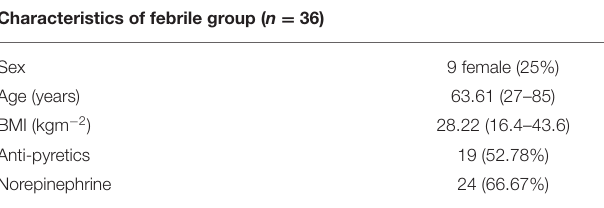
TABLE 1 | Characteristics of the febrile